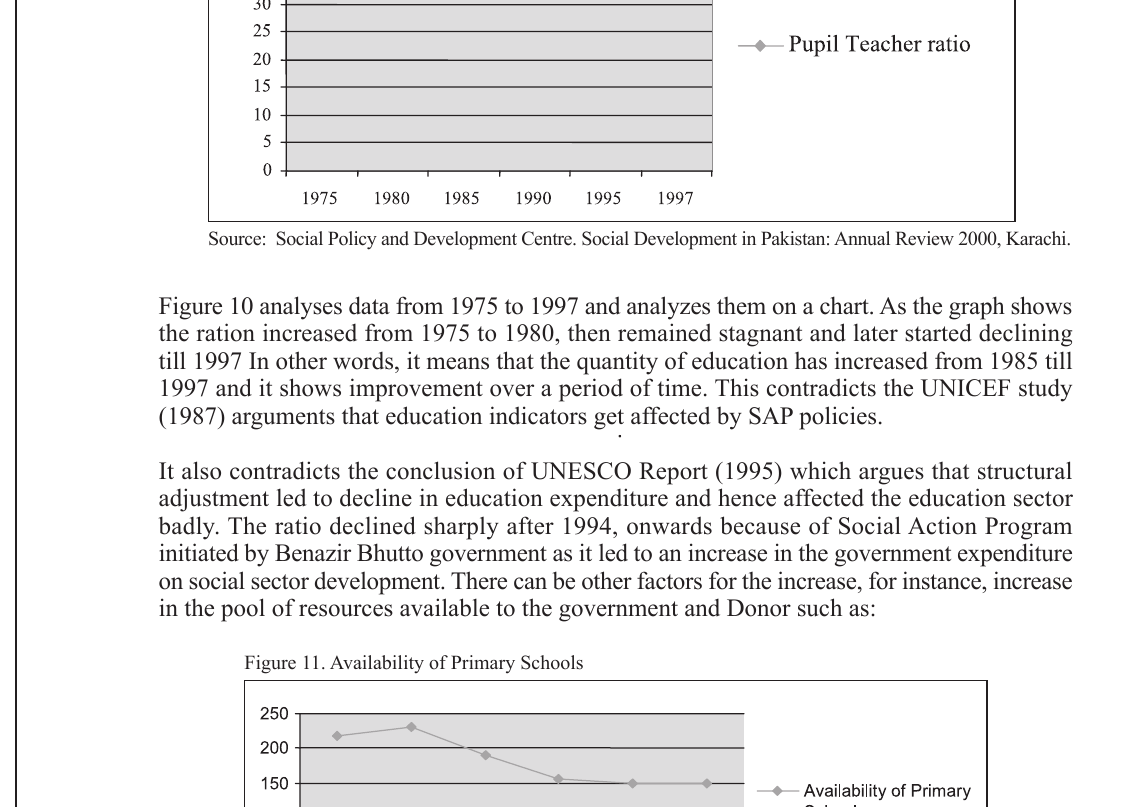
Figure 10. Pupil to teacher ratio